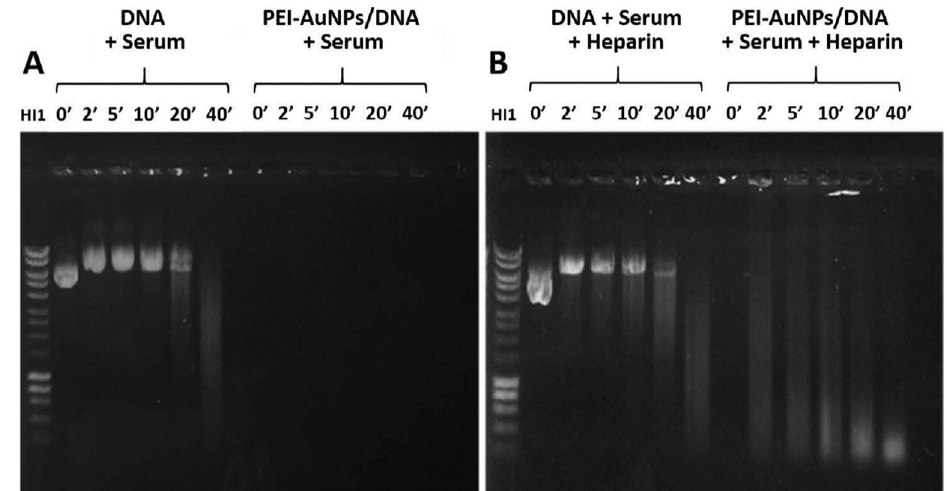
Figure 3. Protection of DNA nuclease degradation. These electrophoresis gels show samples of DNA (p3C eGFP) or PEI ‐ AuNPs/DNA incubated during different times in the presence of serum ( A ) or serum + heparin ( B ). The relation of PEI ‐ AuNPs/p3C eGFP used was 1:2.5 ( μ g/ μ g).